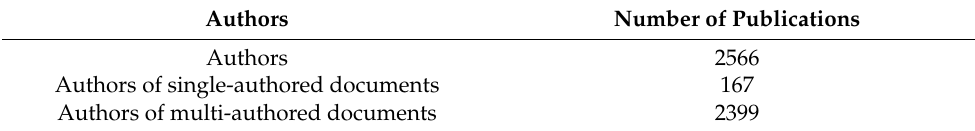
Table 4. Distribution of authors of single and multiple documents.